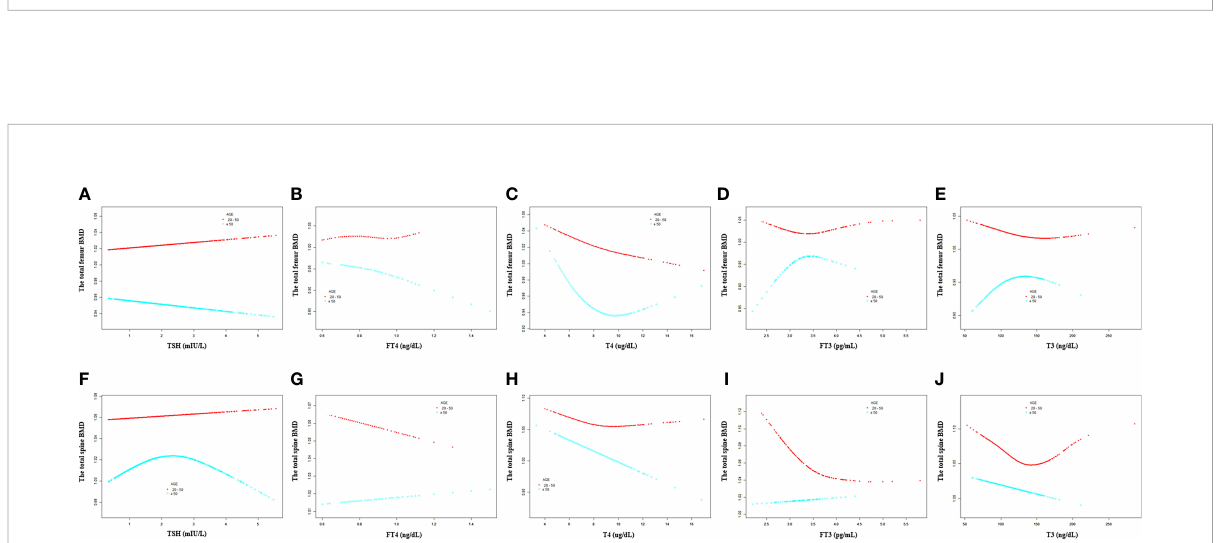
FIGURE 4 Association between the thyroid hormone pro fi le and BMD strati fi ed by age. (A – E) TSH, FT4, T4, FT3, and T3 with the total femur BMD. (F – J) TSH, FT4, T4, FT3, and T3 with the total spine BMD. Solid rad line represents the smooth curve fi t between variables. Blue bands represent the 95% con fi dence interval from the fi t. Gender, age, education, race, ratio of family income to poverty, hypertension, diabetes, BMI, smoking status, alcohol intake, serum creatine, serum triglyceride, serum total calcium, ALP, and AST were